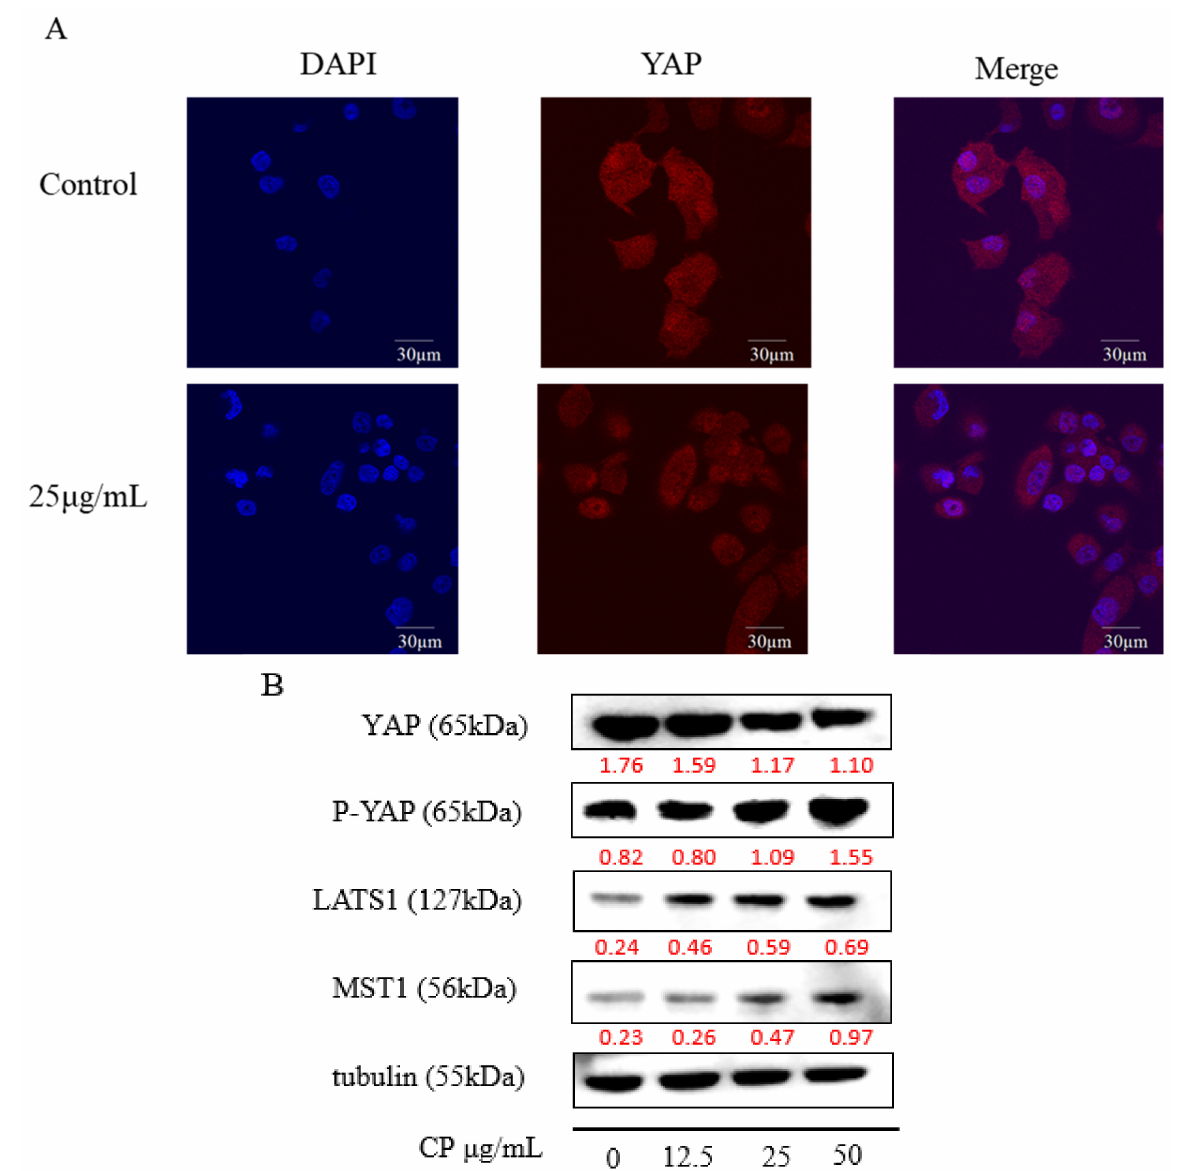
Figure 6. CP exerted an anti-tumor effect on Panc-1 cells by regulating the Hippo-YAP pathway. ( A ) Immunofluorescence image of YAP in Panc-1 cells treated with CP for 48 h. ( B ) The expression of the main components in the Hippo-YAP pathway, including YAP, p-YAP, LATS1, and MST1, detected by Western